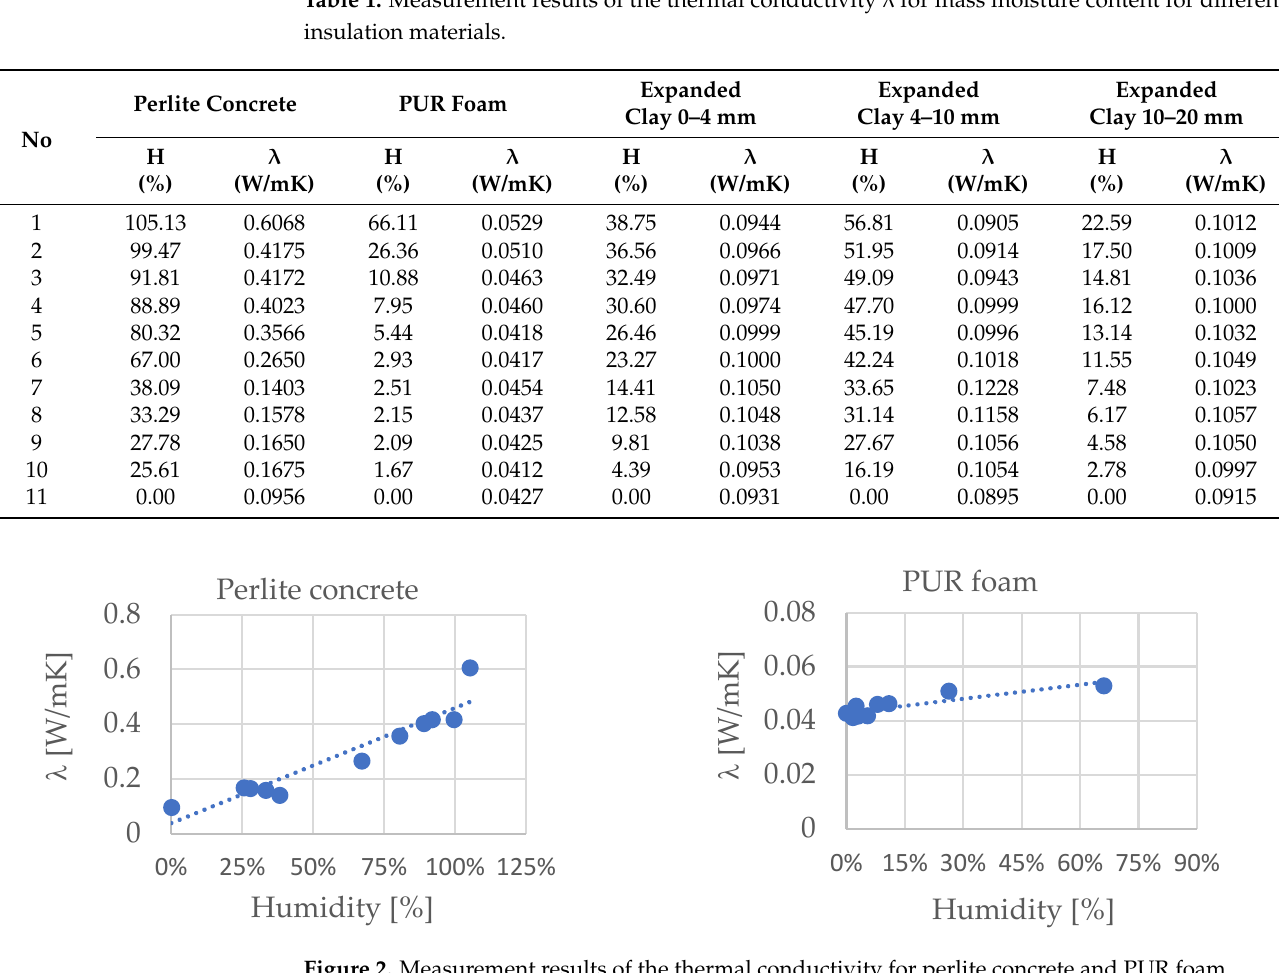
Figure 2. Measurement results of the thermal conductivity for perlite concrete and PUR foam.